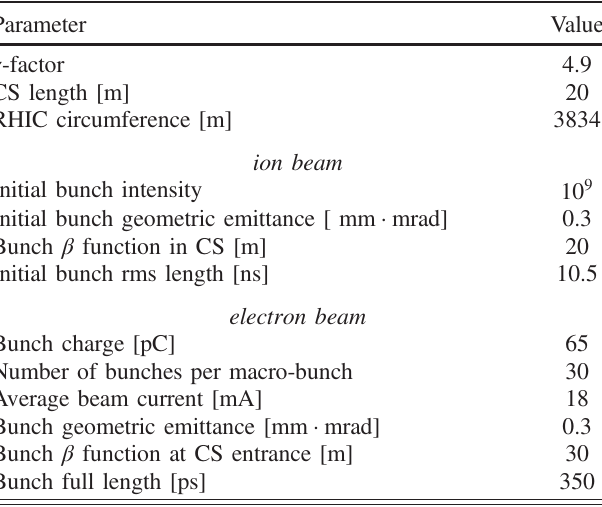
TABLE I. Ion and electron beam parameters.